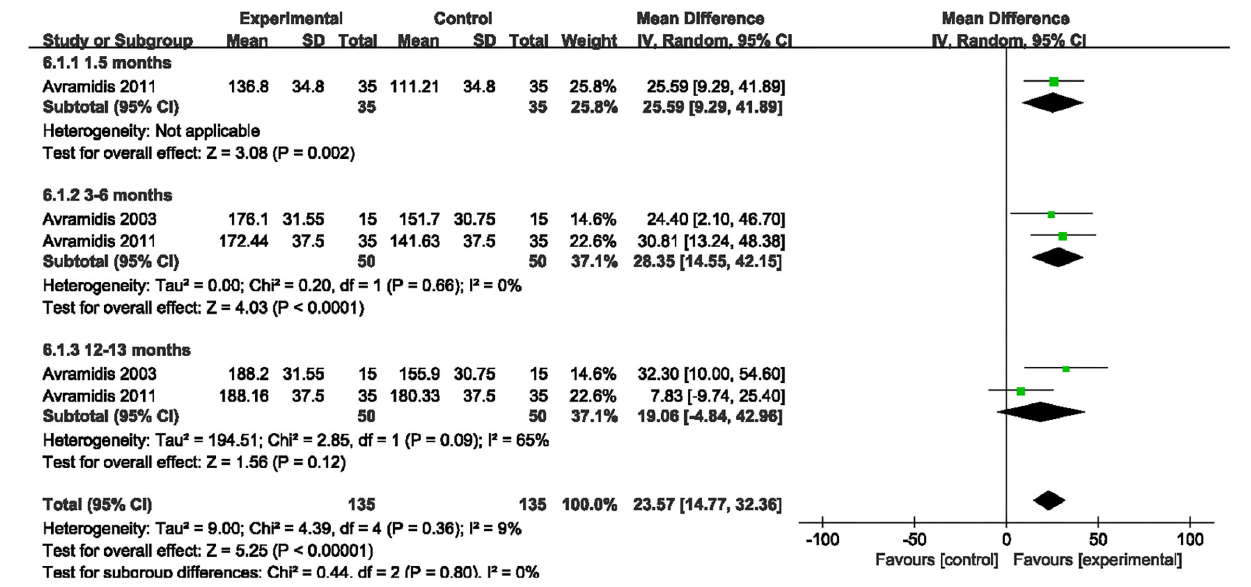
FIGURE 10 | Forest plots of meta-analysis of the effect of NMES vs. conventional rehabilitation on 3 minutes walk test.